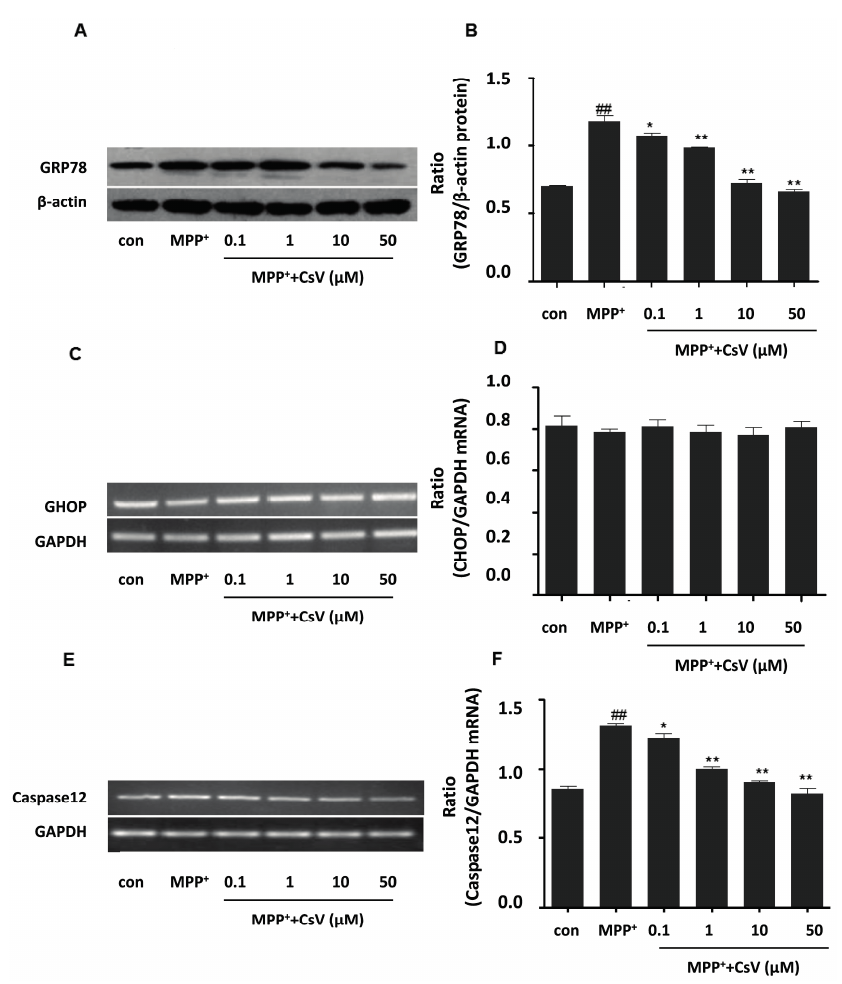
Figure 5. CsV ameliorated MPP + -induced endoplasmic reticulum (ER) stress in SH-SY5Y cells. ( A ) Western blot analysis of GRP78 and β -actin protein levels; ( B ) Data quantification of panel ( A ). Western blot was quantified and expressed as the ratio of GRP78 and β -actin intensity; ( C ) PCR analysis of C/EBP homologous protein (CHOP) and GAPDH mRNA levels; ( D ) Data quantification of panel ( C ). PCR was quantified and expressed as the ratio of CHOP and GAPDH intensity; ( E ) PCR analysis of Caspase12 and GAPDH mRNA levels; and ( F ) Data quantification of panel ( E ). PCR was quantified and expressed as the ratio of Caspase12 and GAPDH intensity. ## p < 0.01 vs. control